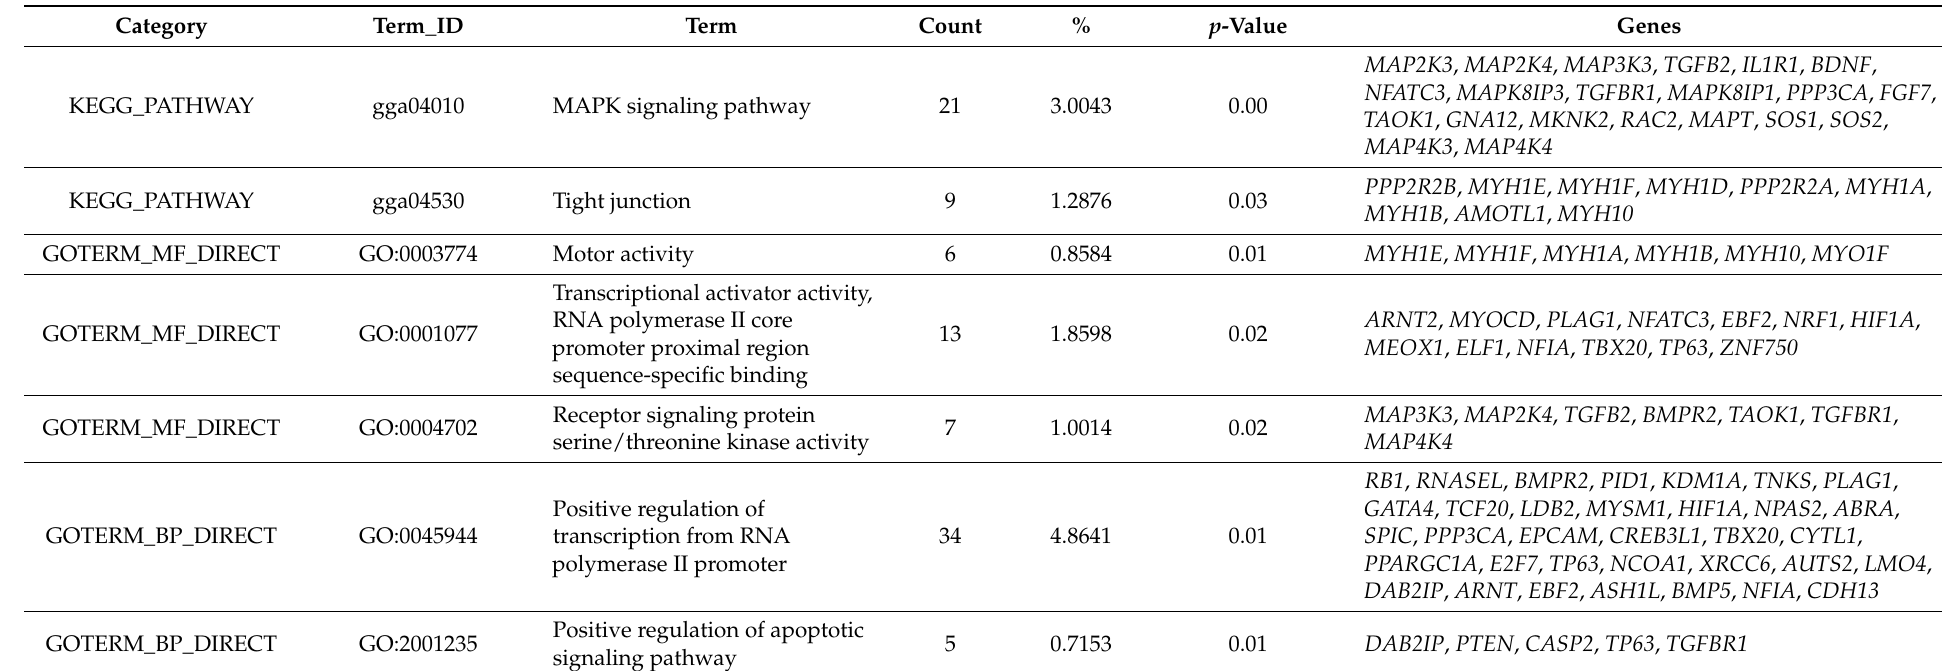
Table 4. Gene Ontology (GO) terms and Kyoto Encyclopedia of Genes and Genomes (KEGG) pathways significantly enriched ( p < 0.05) for genes associated with body weight.